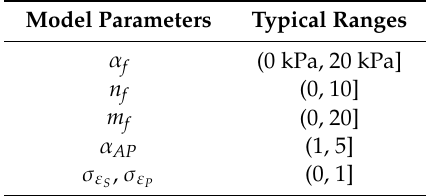
Table 1. Typical ranges of model